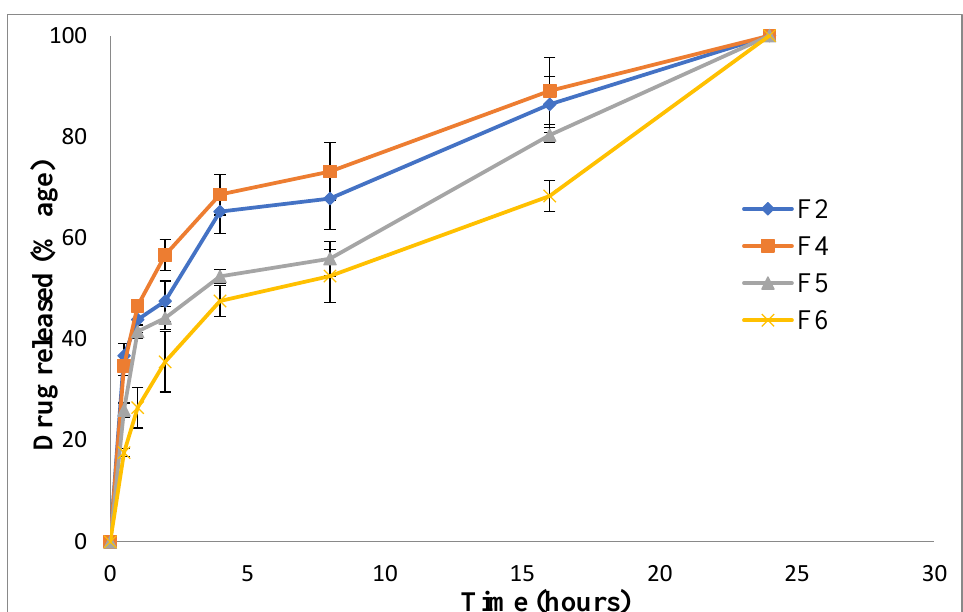
Figure 6. XRD analysis of selected nanoparticulate formulations.